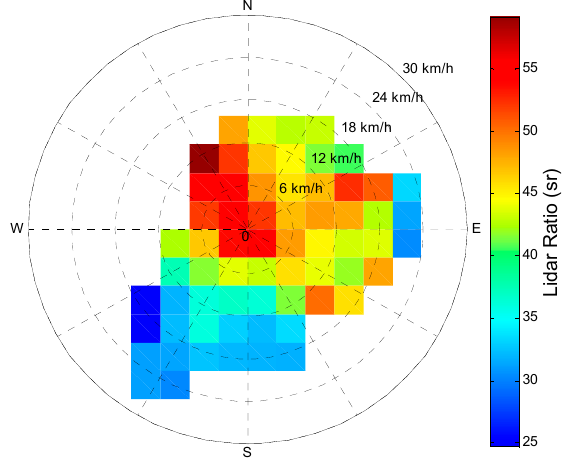
Figure 7. Variation in aerosol lidar ratios as a function of wind direction (°) and speed (km/h).